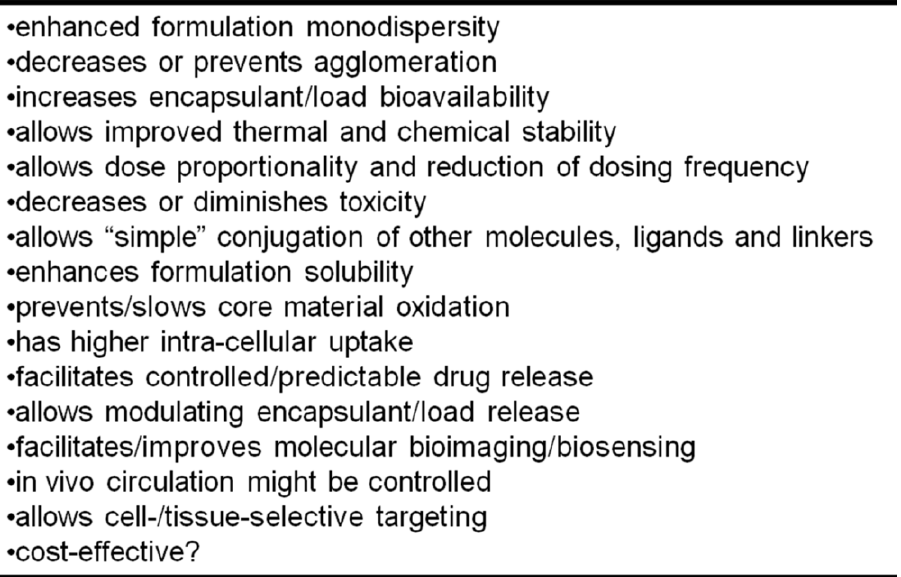
Figure 1. Advantages of Core-Shell Architectured NanoSystems in